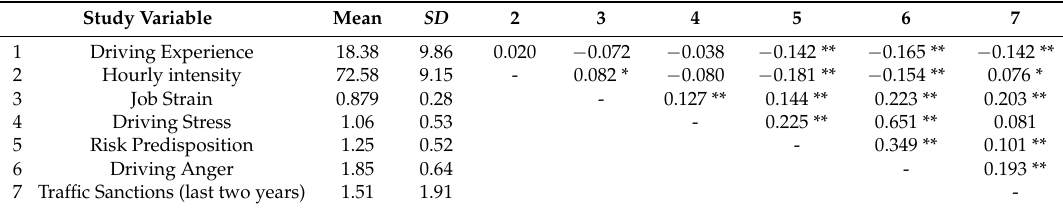
Table 1. Descriptive statistics and bivariate correlations between study variables.